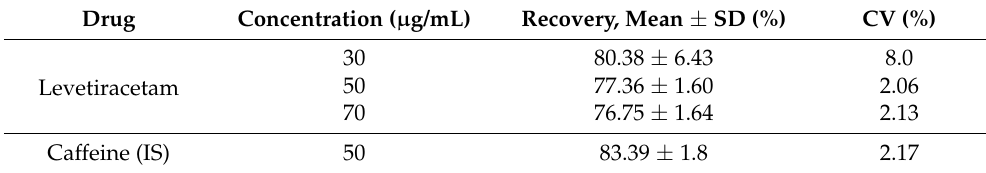
Table 3. Mean percent recovery for Levetiracetam and Caffeine